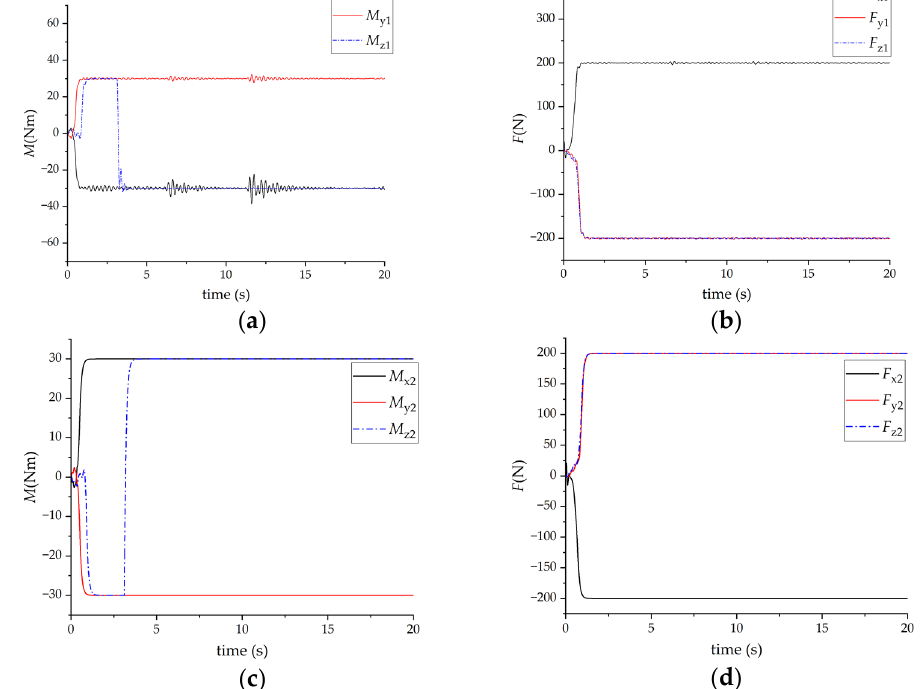
Figure 19. The output of the virtual force sensor in the second experiment: ( a ) output torque profiles of the virtual force sensor 1; ( b ) output force profiles of the virtual force sensor 1; ( c ) output torque profiles of the virtual force sensor 2; and ( d ) output force profiles of the virtual force sensor 2.